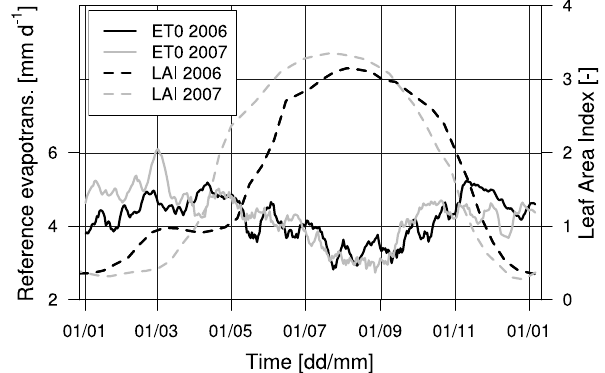
Fig. 3. Annual cycle of the reference evapotranspiration ET 0 (10- day moving average filter, solid lines) and of the leaf area index (LAI; averages from a composite of satellite products, dashed lines) for 2006 (black lines) and 2007 (grey